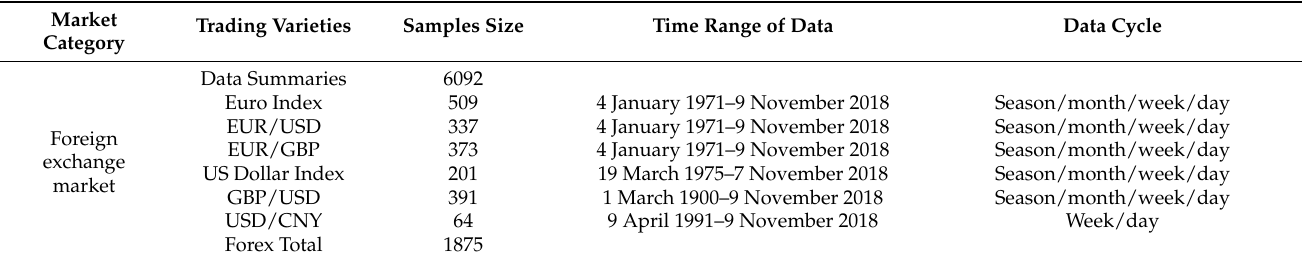
Table 2. Basic information about the